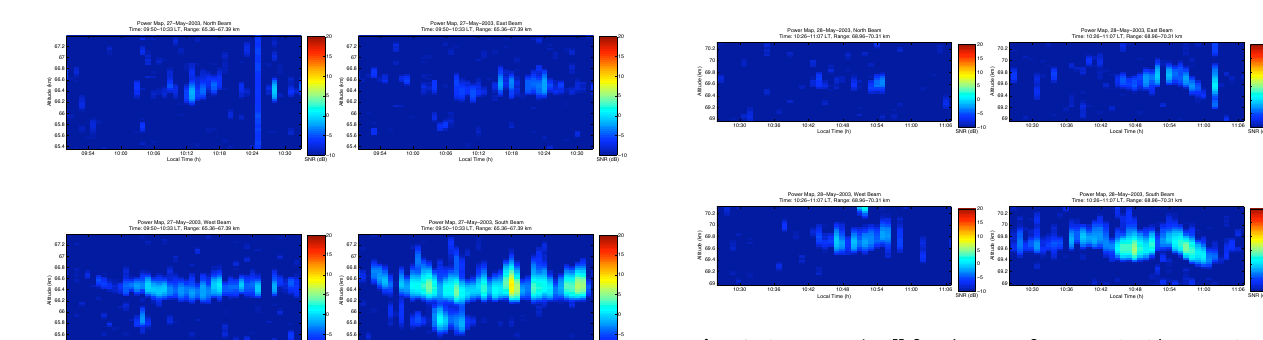
Fig. 19. SNR map in all four beams of event at 69.6 km on May 28, 2003 at 10:30 LT.